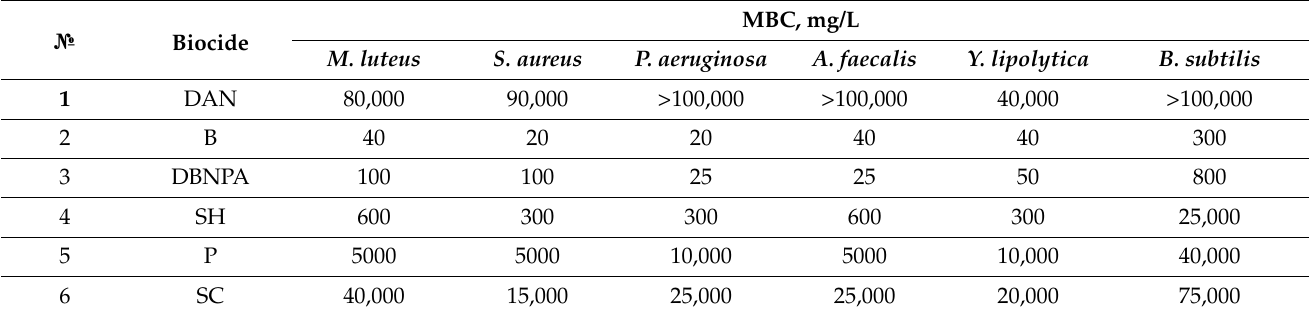
Table 2. MBC of the studied biocides for test-microorganisms.